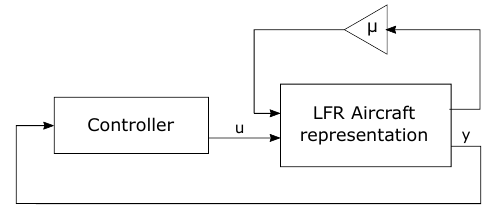
Figure 1. Representation of integrated design and control